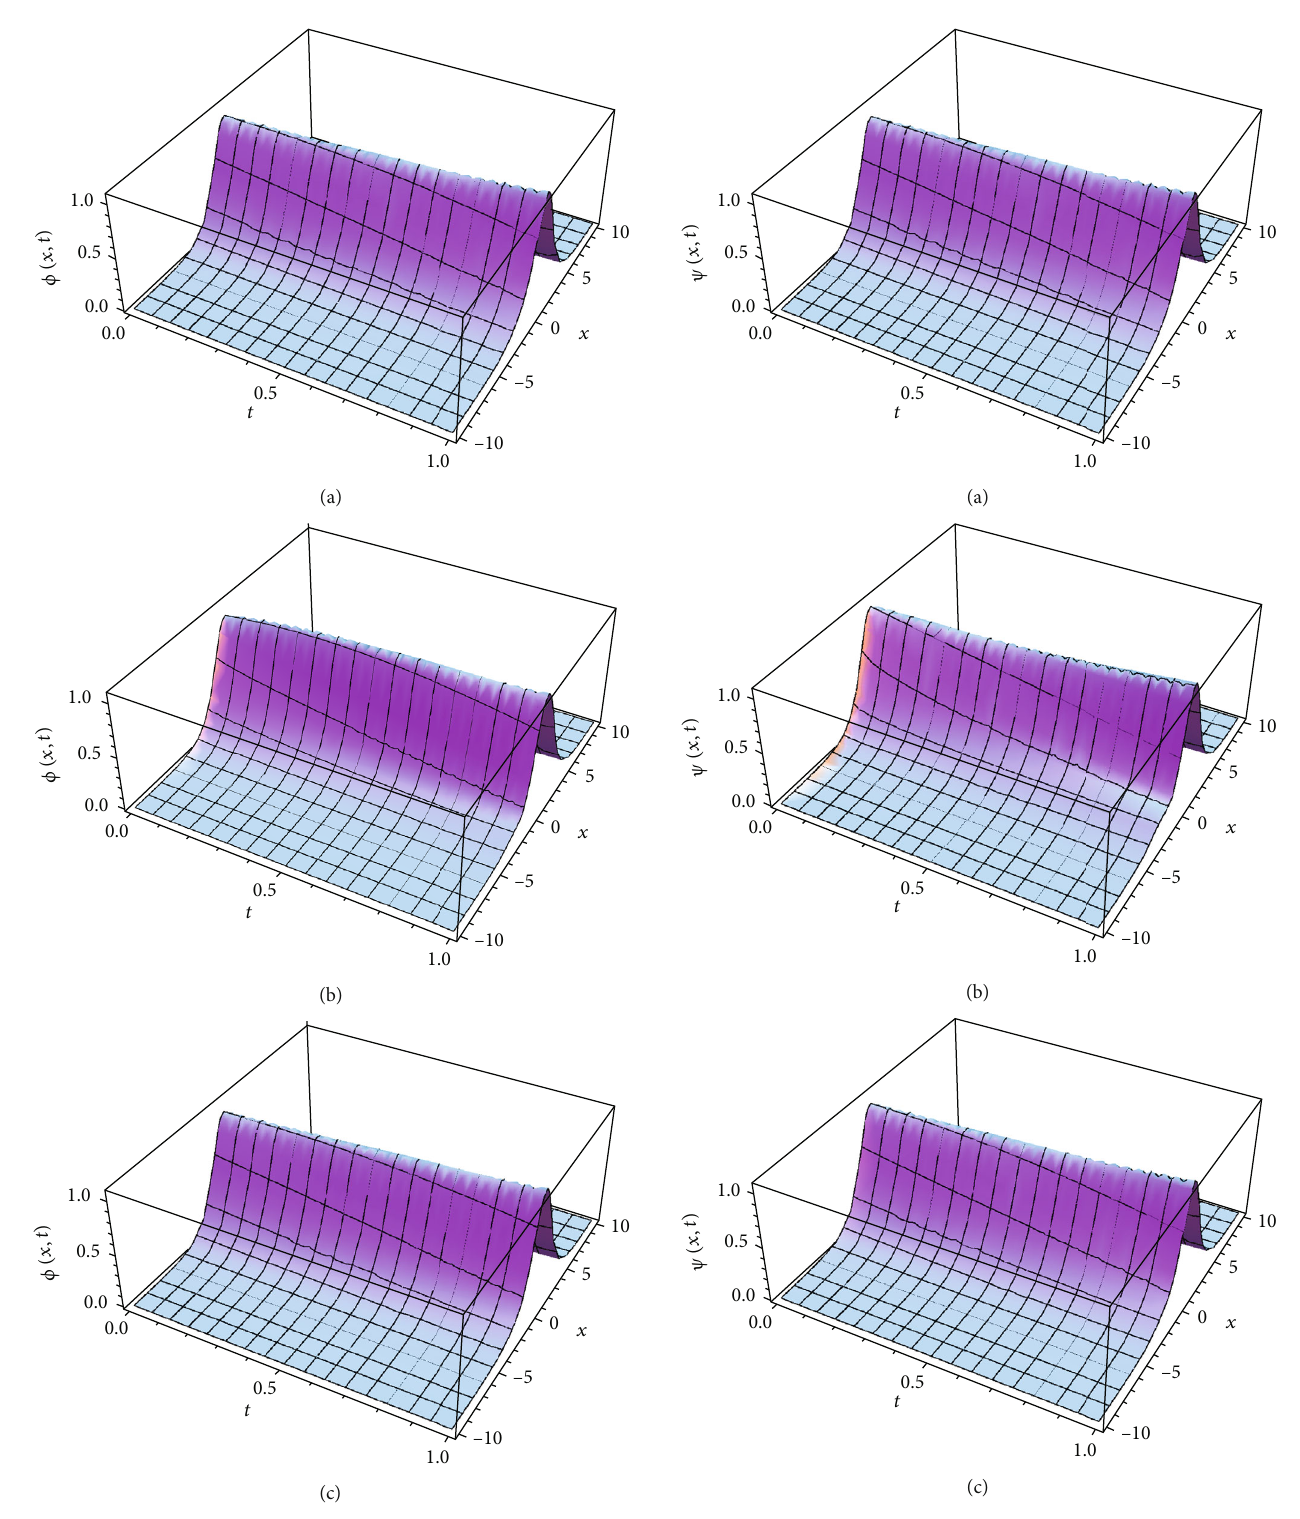
Figure 4: The NDM solutions ψ ð x , t Þ for Example 2 when c = 1 : (a) α = 1, β = 1 ; (b) α = 0 : 75, β = 0 : 5 ; (c) α = 1, β = 0 : 90